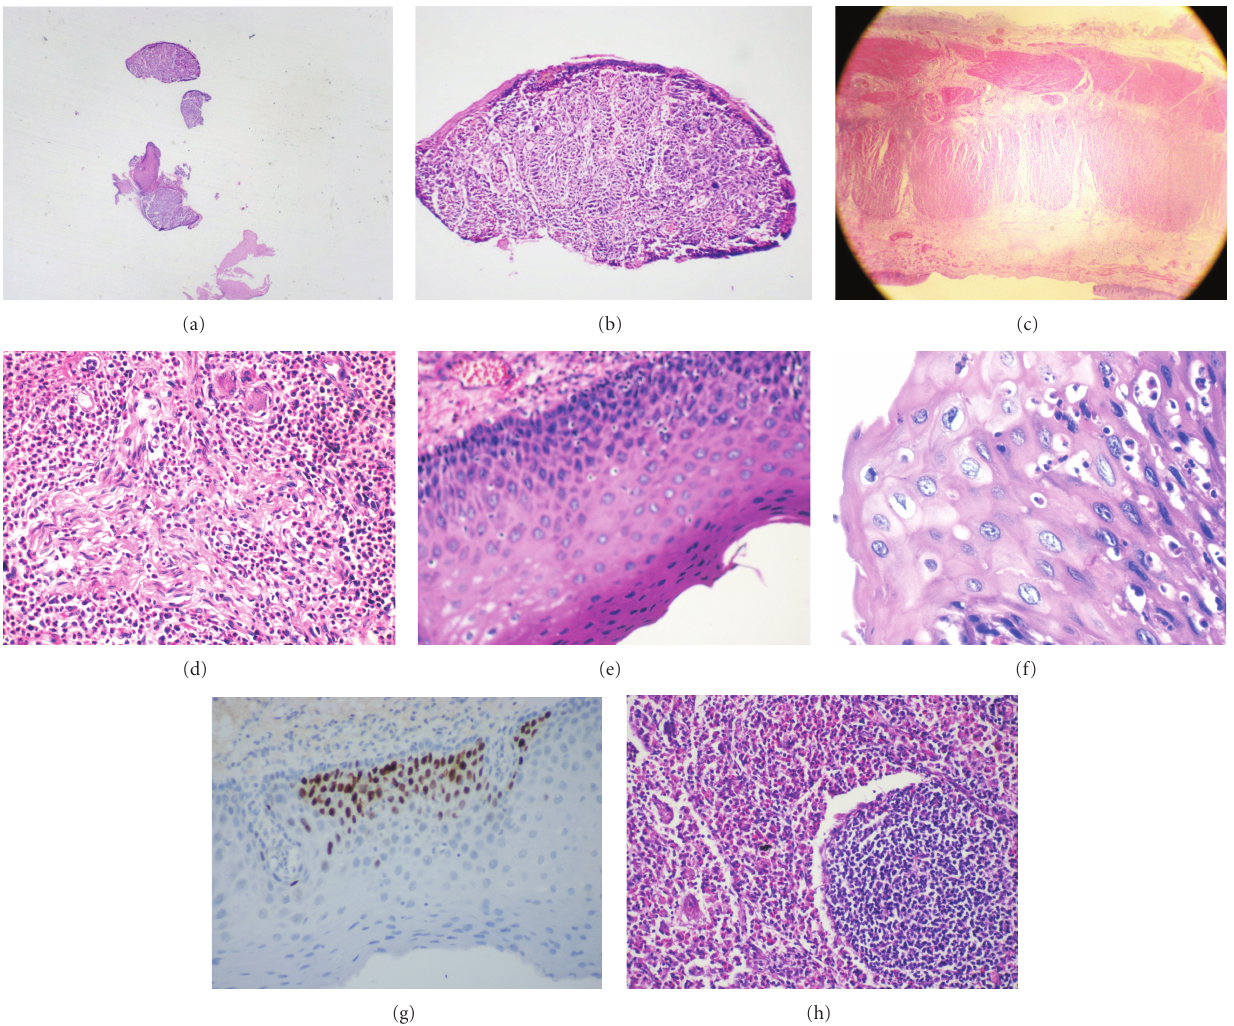
Figure 2: Histologic examination. (a) Presence of three lesions between the normal tissue. (b) Superficial squamous cell carcinoma with infiltration of eosinophils into the tumor cells and lamina propria. (c) Presence of mucosal coloboma. (d) The eosinophils infiltrated the muscle fiber and nerve plexus. (e) Presence of basal hyperplasia. (f) Changes in polarity and size of the cell and nuclei. (g) Basal parabasal cells expressed p53. (h) Eosinophils invaded the lymph nodes.